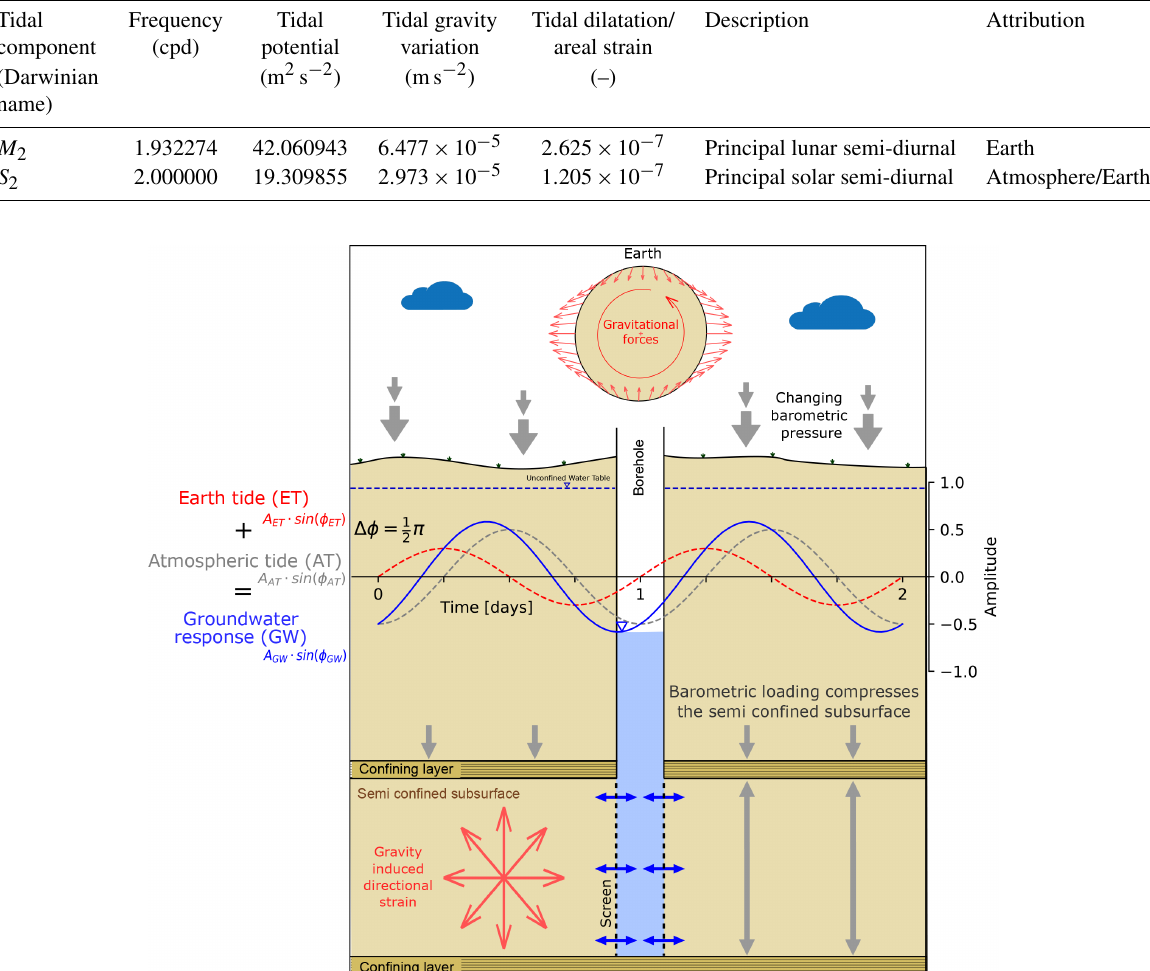
Table 1. M 2 and S 2 tidal components, tidal potential, gravity, and dilatation using tidal predictions (this does not include local variations). Extracted from Agnew (2010) and McMillan et al. (2019).